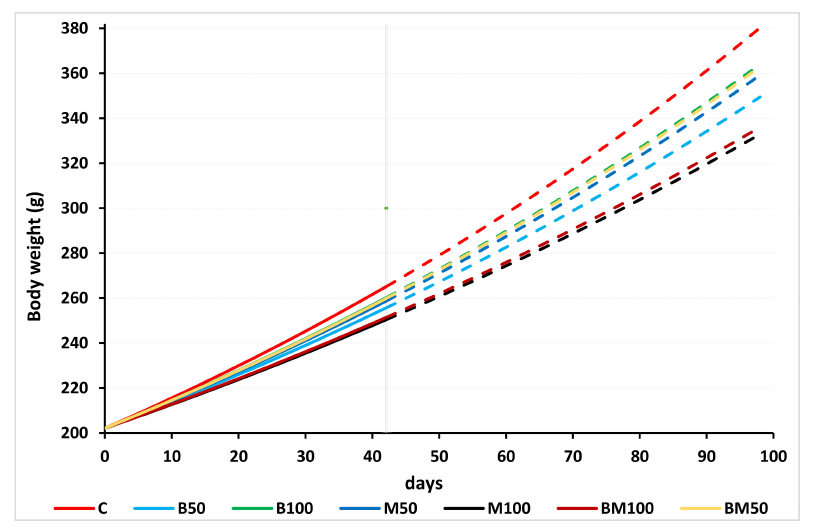
Figure 3. Simulation of growth of fish fed under different treatments using the parameterized exponential growth function (Table